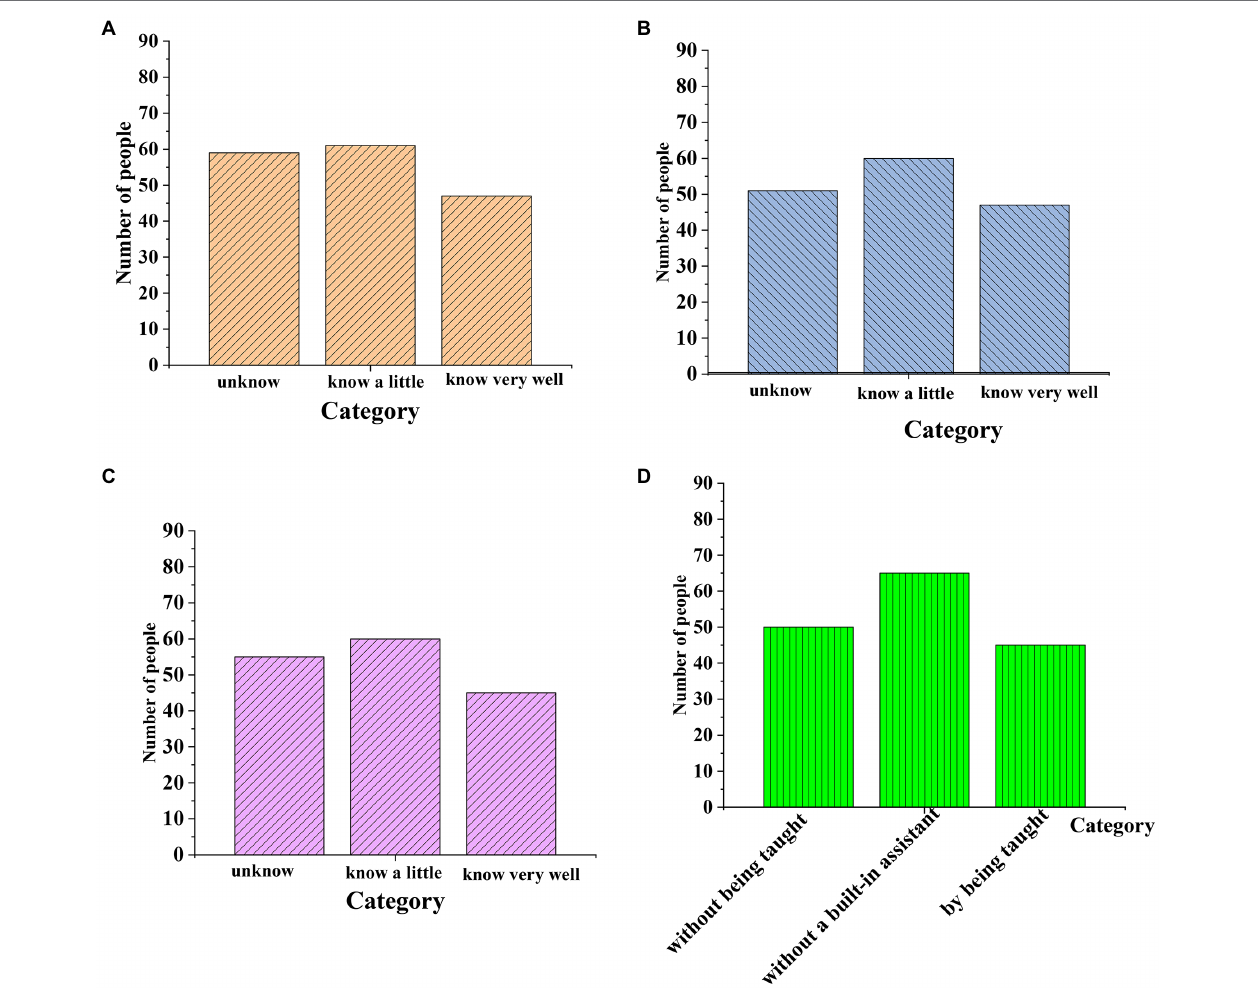
FIGURE 4 | QS analysis results: (A) shows the degree of understanding of entrepreneurial training, (B) S illustrates the degree of understanding of entrepreneurial policies, (C) indicates the understanding of regional advantages, and (D) reveals the self-efficacy of